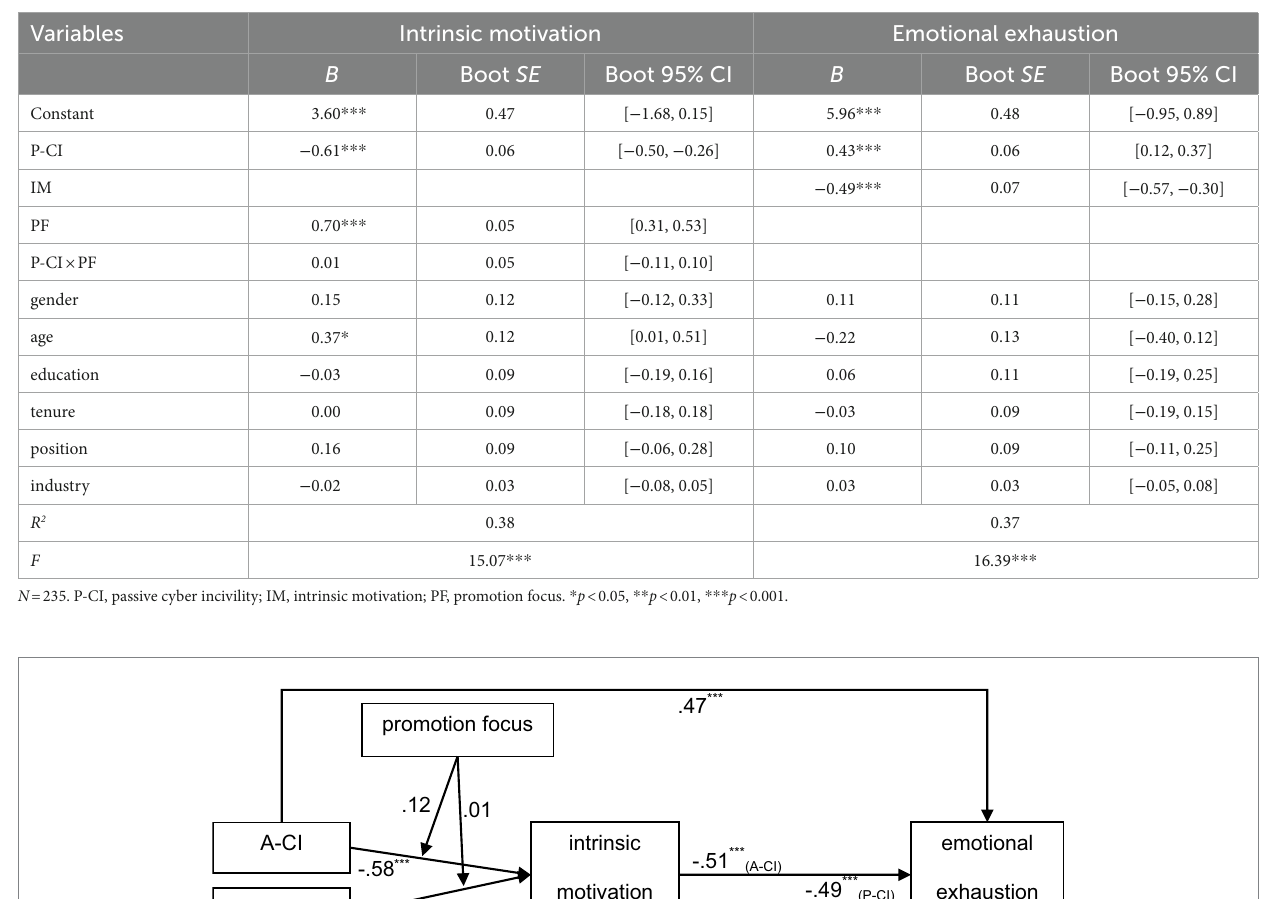
TABLE 5 Regression coefficient estimates of passive cyber incivility in Study 2.